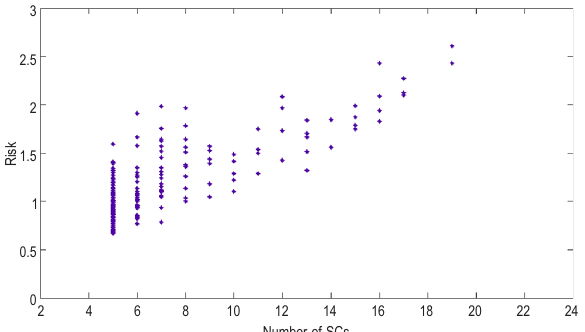
Fig. 6. The interaction of risk and number of SCs